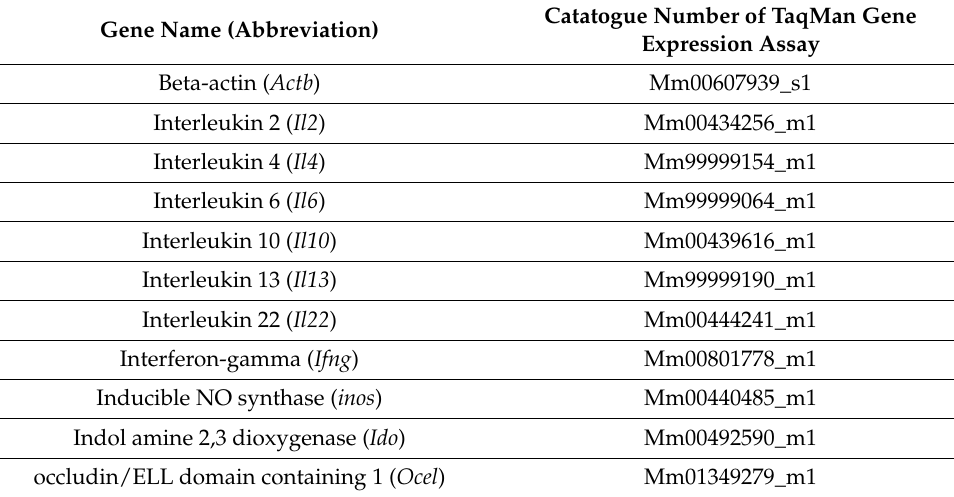
Table 1. List of TaqMan gene expression